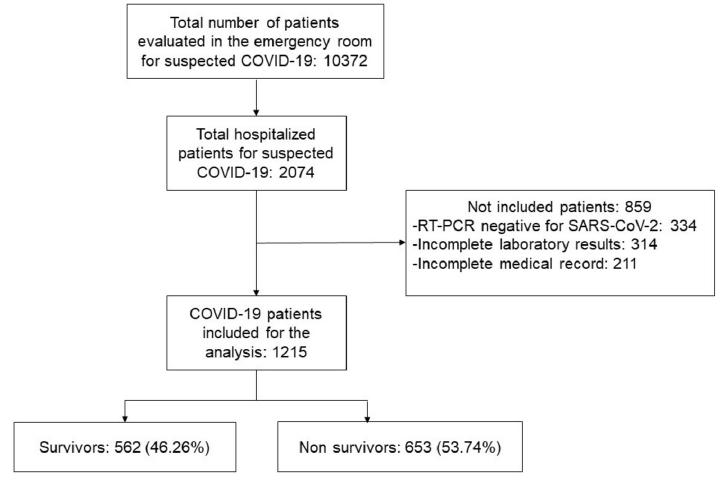
Figure 1. Study flow diagram. Table 1. Baseline characteristics of 1215 hospitalized patients with a diagnosis of